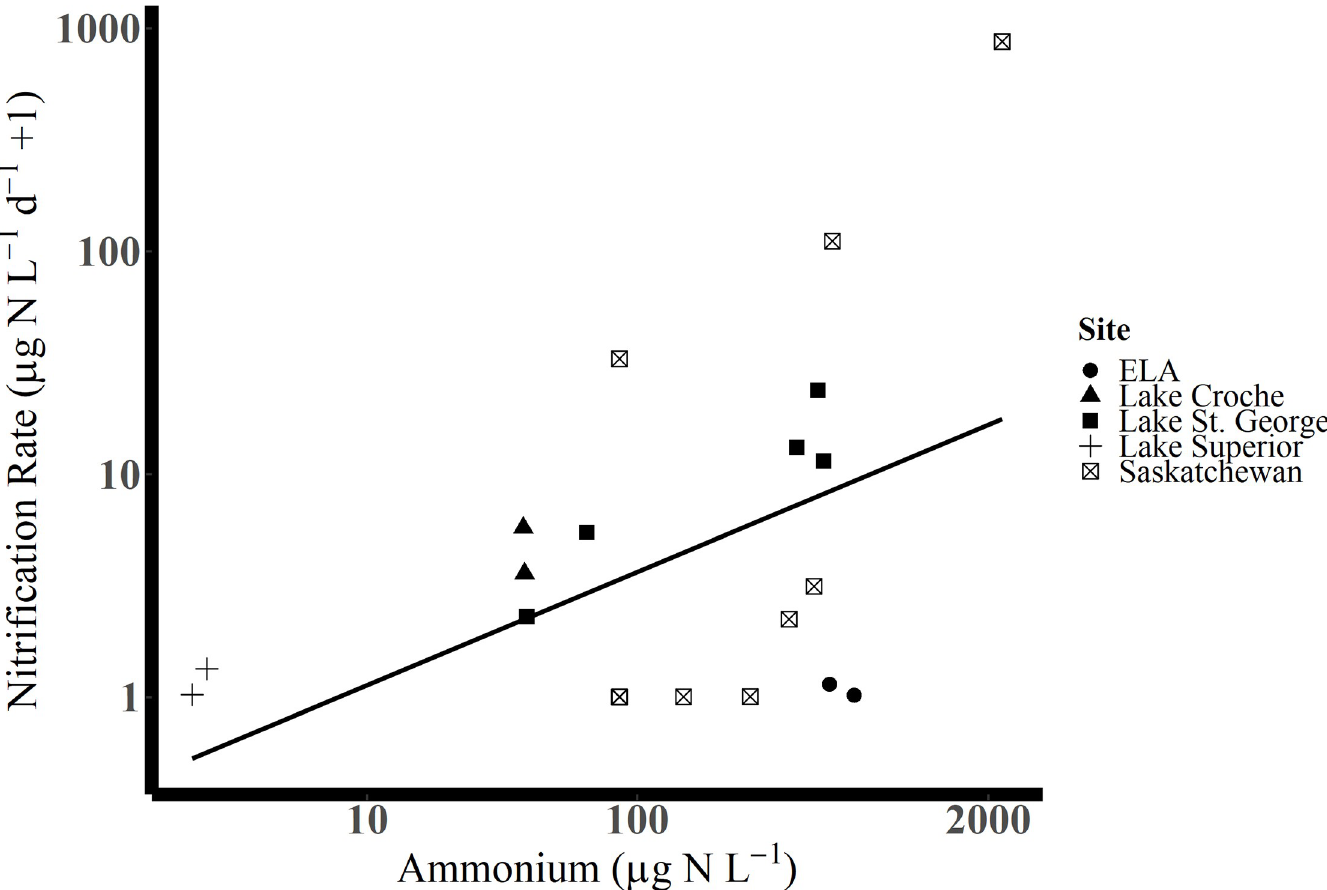
Fig 3. Relationship between nitrification rates and NH 4+ concentrations for water bodies from this study (ELA and Saskatchewan) and other cold water measurements from Lake Superior (no ice-cover; [40]), Lake St. George (ice-covered; [21]) and Lake Croche (ice-covered; [38]). Note logged y-axis. The line plotted is the linear model (permutations) for all data from Tables 1 and 2. The linear model and statistics are presented in Table 3. Nitrification rates less than their sample specific LOQ are replaced by their LOQ.